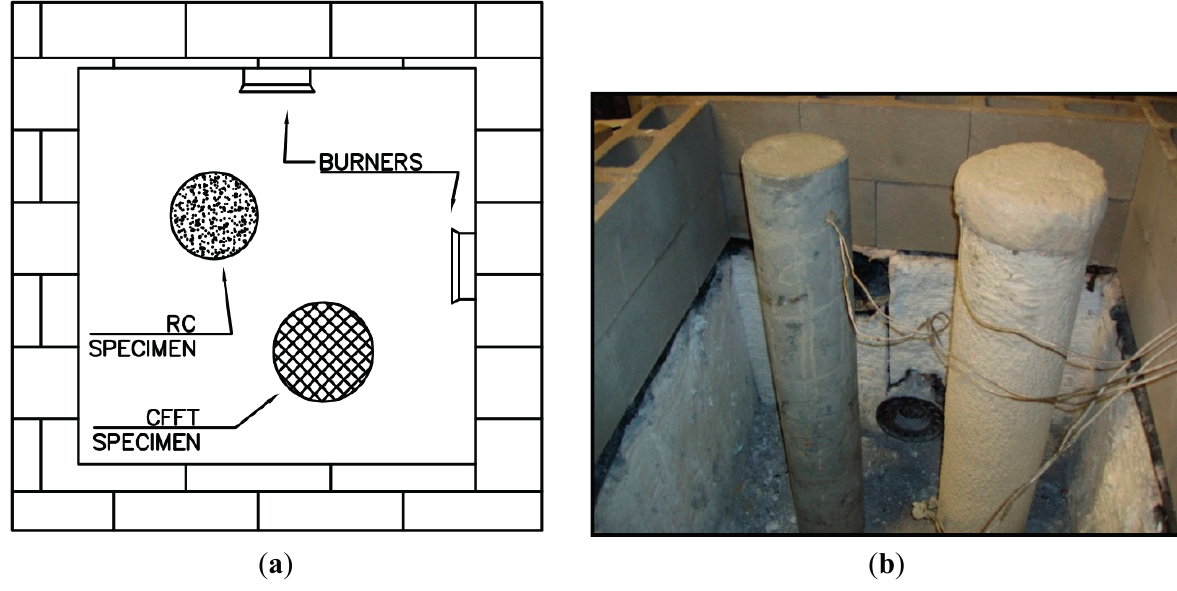
Figure 9. ( a ) Plan-view schematic of test setup and ( b ) test set-up